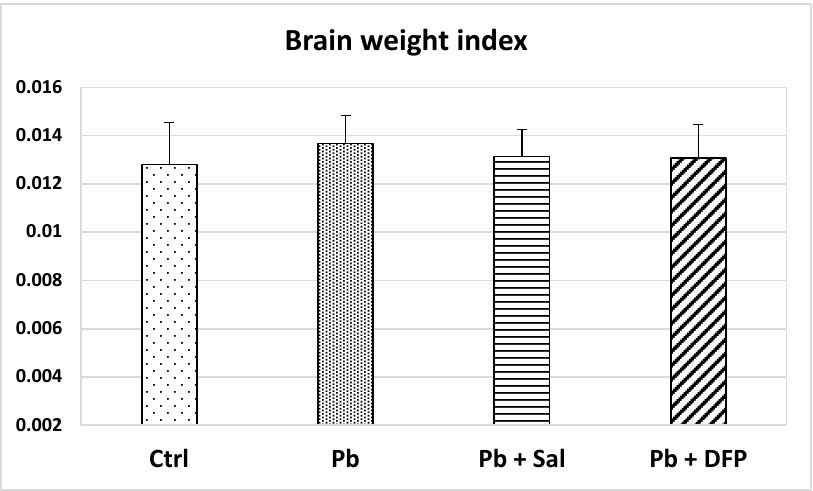
Figure 1. Brain weight index in untreated control mice (Ctrl), Pb-exposed mice (Pb), and Pb-exposed mice treated with salinomycin (Pb + Sal) or deferiprone (Pb + DFP). Data are presented as mean + standard deviation (SD).